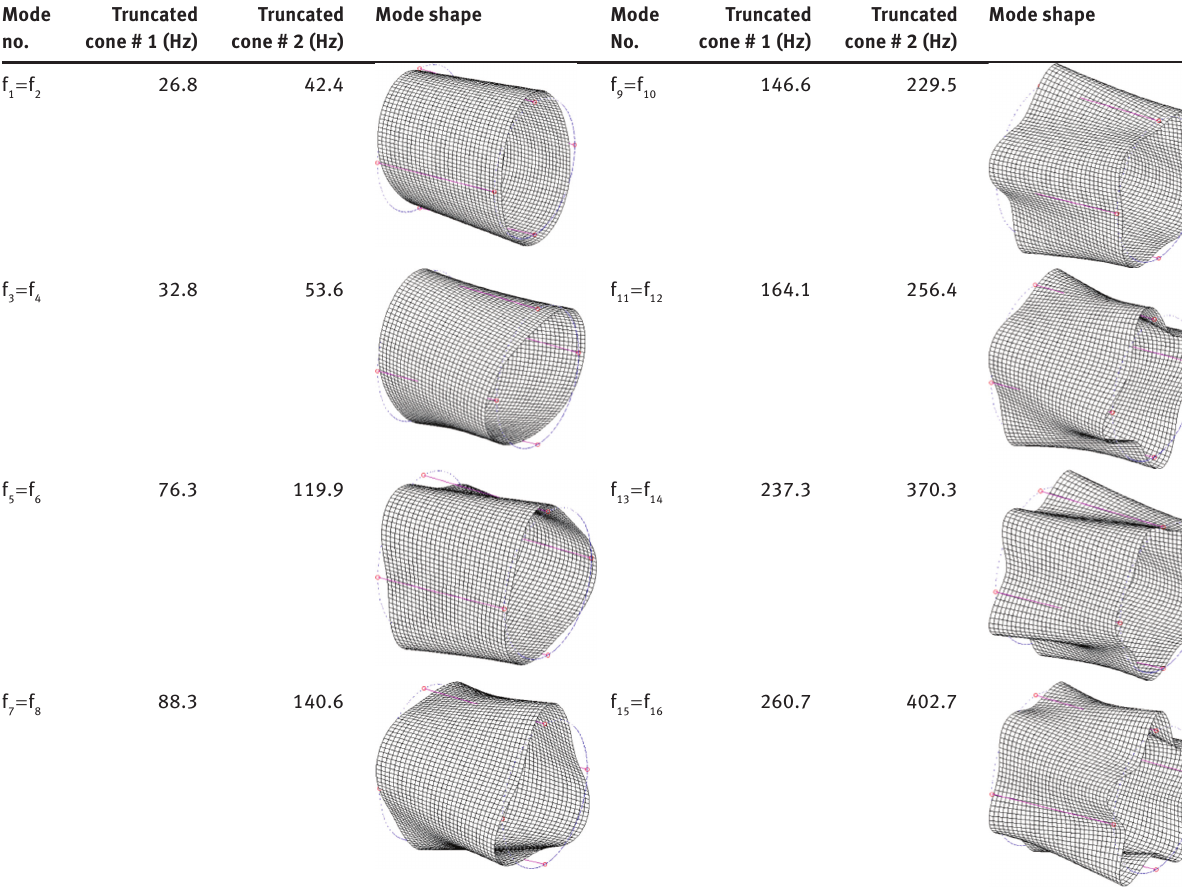
Table 7: Theoretical natural frequencies and mode shapes of two truncated cones (before autoclave).